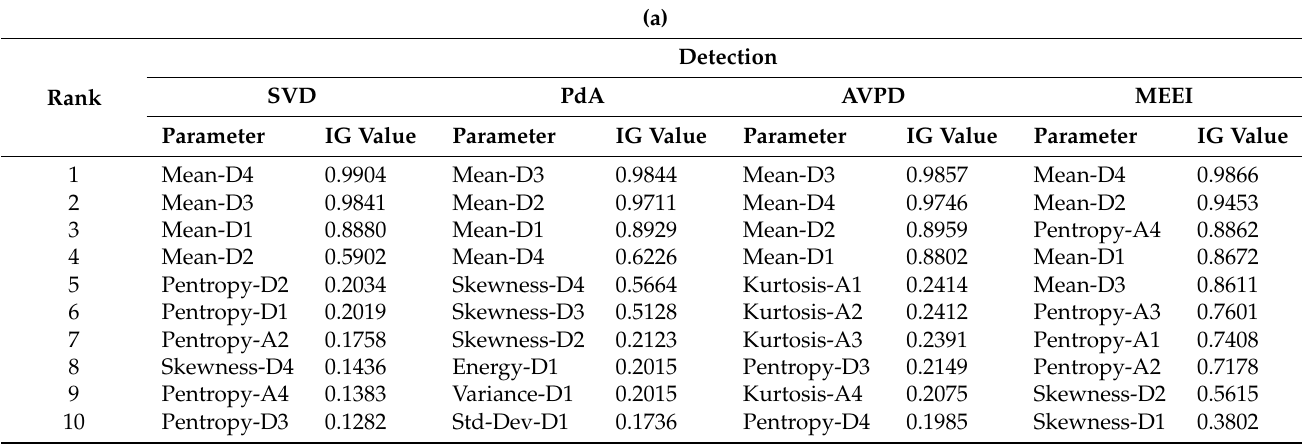
Figure 7. Density plots for top three descriptors for multiclass classification process: ( A ) Density plot for Mean-D4 parameter of SVD, ( B ) Density plot for Mean-D3 parameter of SVD, ( C ) Density plot for Mean-D2 parameter of SVD, ( D ) Density plot for Mean-D2 parameter of PdA, ( E ) Density plot for Mean-D3 parameter of PdA, ( F ) Density plot for Mean-D1 parameter of PdA, ( G ) Density plot for Mean-D2 parameter of AVPD, ( H ) Density plot for Mean-D4 parameter of AVPD, ( I ) Density plot for Mean-D1 parameter of AVPD, ( J ) Density plot for Mean-D1 parameter of MEEI, ( K ) Density plot for Mean-D2 parameter of MEEI, ( L ) Density plot for Mean-D3 parameter of MEEI. Table 3. (a) Top ten parameters for recognizing voice dysfunction. (b) Top ten parameters for categorizing voice